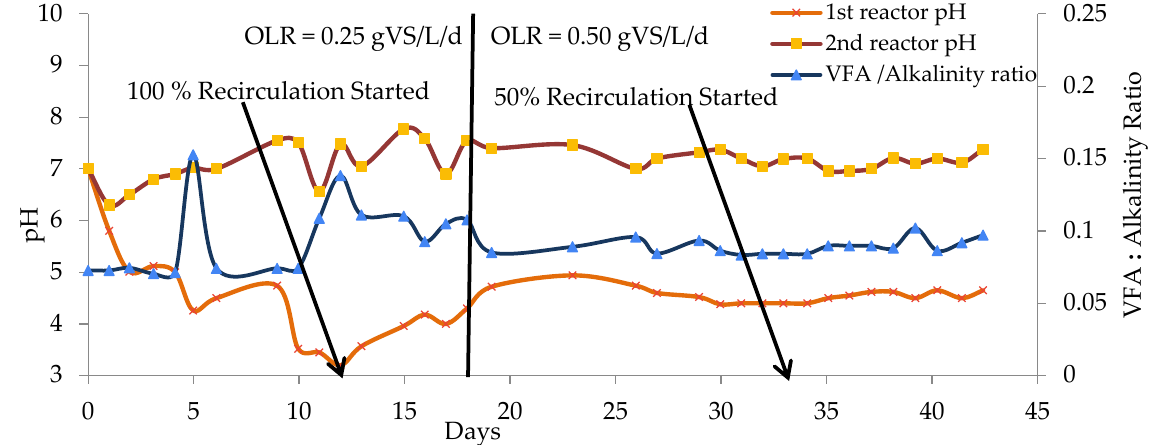
Figure 7. pH and FOS TAC ratio change in reactors of restarted TSAD system.